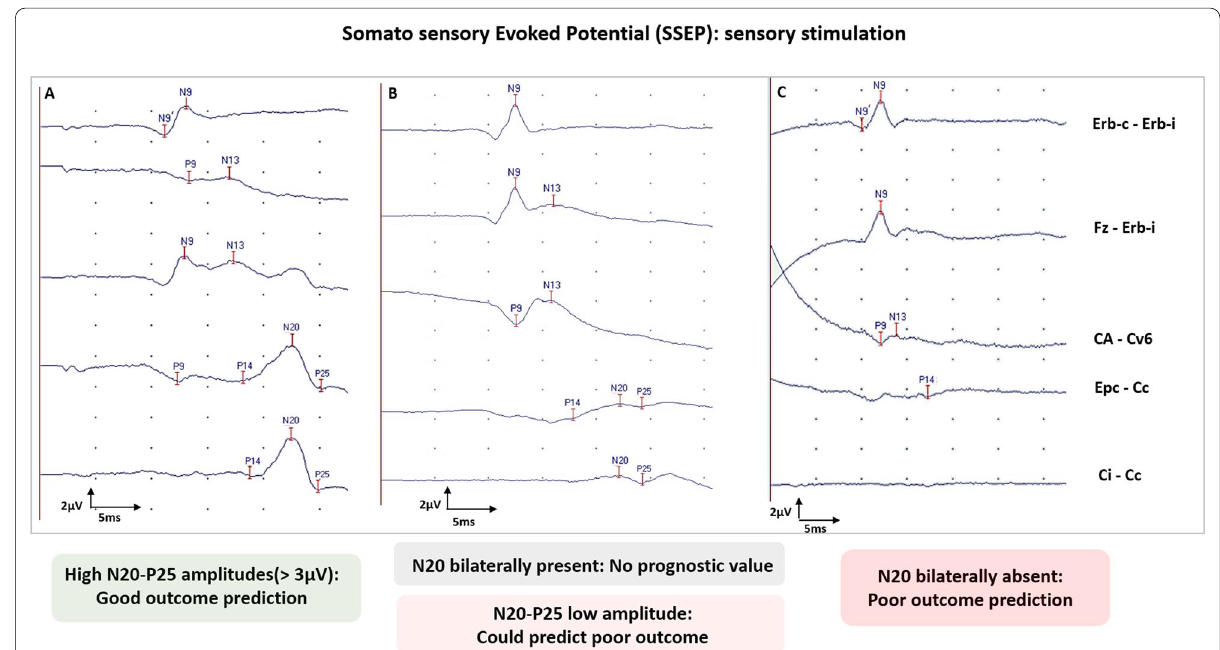
Fig. 3 Somato‑sensory evoked potential (SSEP) interpretation and prognostic value in comatose and DoC patients after CA. SSEPs five channels recording with N9 (proximal part of the median nerve) N13 (posterior columns of the spinal cord) P14 (cervico‑medullar level), N18 (subcortical), N20 and P25 (primary somatosensory cortex). Erb-i Erb point ipsilateral, Erb-c Erb point contralatera, Fz Midline frontal electrod, CA-Cv6 cervical anterior and cervical posterior C6 electrode, Epc-Cc centro‑parietal electrode contralateral to the stimulation (C’3 or C’4) and the shoulder contralateral to the stimulatio, C’3–C’4 centro‑parietal electrode ipsilateral and contralateral to the stimulation. Only one side is here presented. Pre‑requisite for ERP interpretation: N9 and N13 should be present. Use of neuromuscular blockage agents is recommended if artefacts limit the recording. Part A Shows that N20 and P25 are present with a high N20–P25 amplitude. Part B Shows that N20 and P25 are present with a low N20– P25 amplitude. Part C Shows an absence of N20 and P25, with preserved N9 and N13